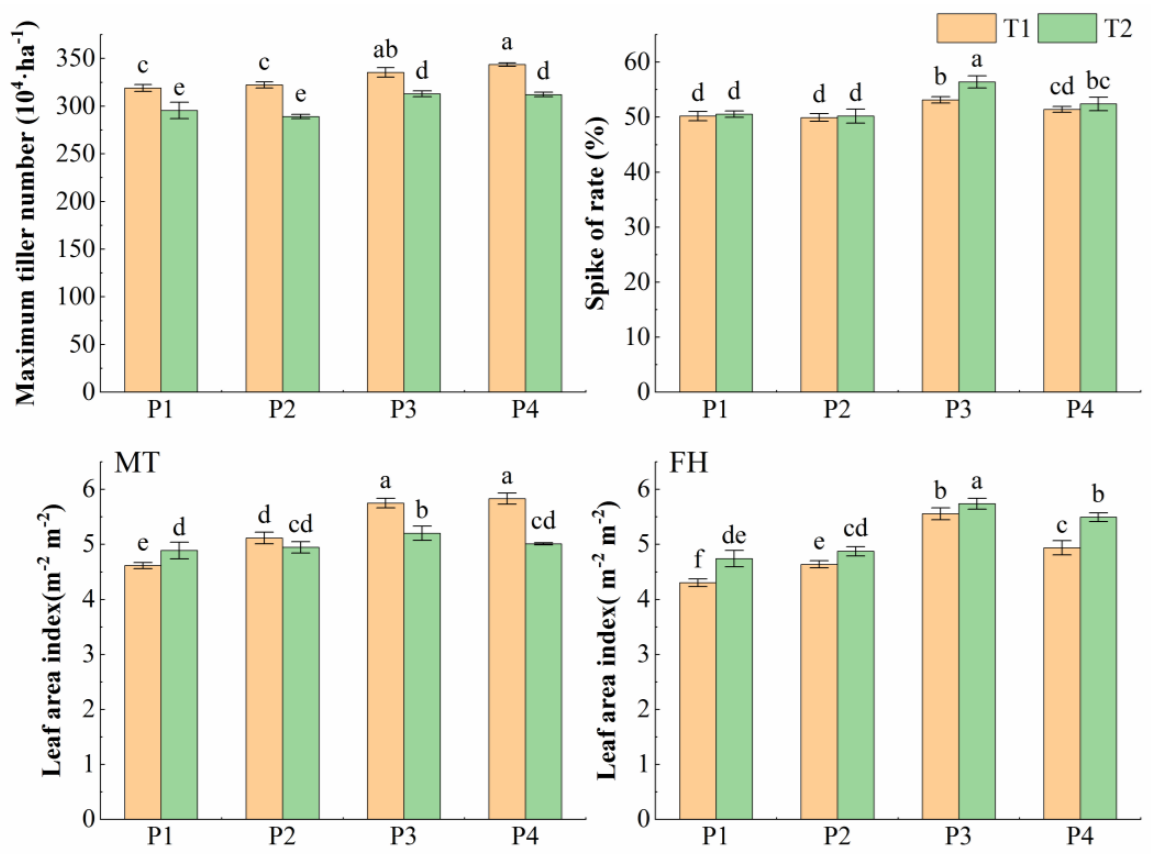
Figure 2. Maximum tiller number, spike rate and leaf area index under different treatments in 2020. Note: T1, no straw return; and T2, straw returning. P — No P application; P2 — P application on both rapeseed and rice; P3 — P application on rapeseed; P4 — P application on rice; MT: Maximum tillering stage; FT: full heading stage; Different small letters indicate significant differences among treat- ments at p < 0.05 level.